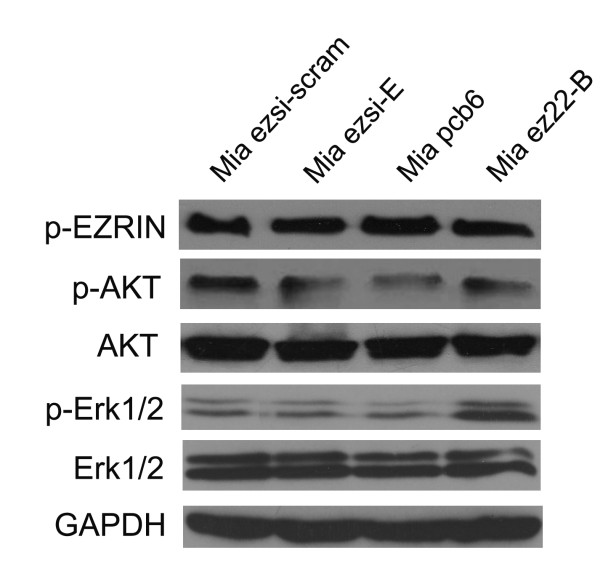
Ezrin overexpression increasing the level of phosphorylated Erk1/2 in MiaPaCa-2 cells. The levels of phosphorylated-ezrin, total AKT, phosphorylated-AKT, total Erk1/2 and phosphorylated Erk1/2 were determined by western blot in the Mia ezsi-scram, Mia ezsi-E, Mia pcb6 and Mia ez22-B cells. GAPDH was used as a loading control.